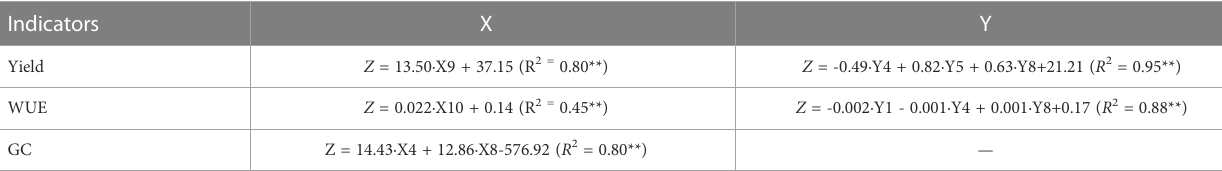
TABLE 4 Multiple regression equations of groundwater consumption (GC), yield, and water use ef fi ciency (WUE) on growth and water utilization indicators. Indicators